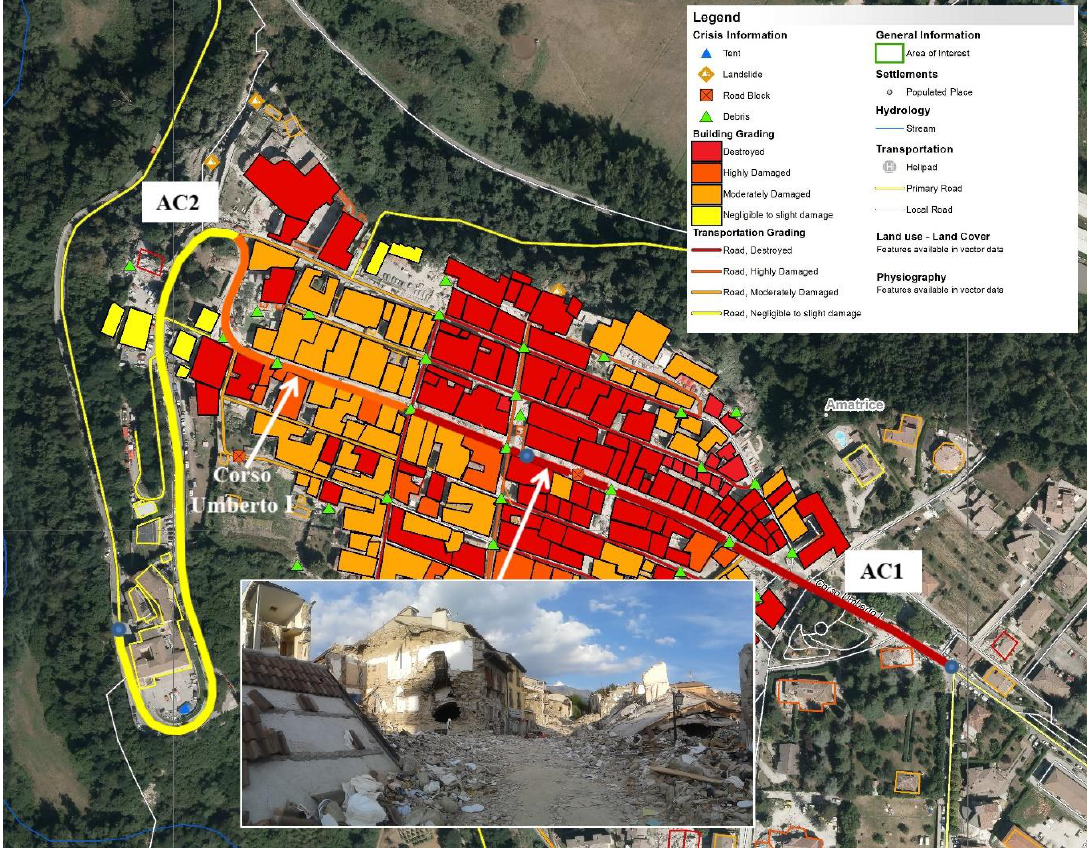
Figure 12. Map of damage along Corso Umberto I [25].